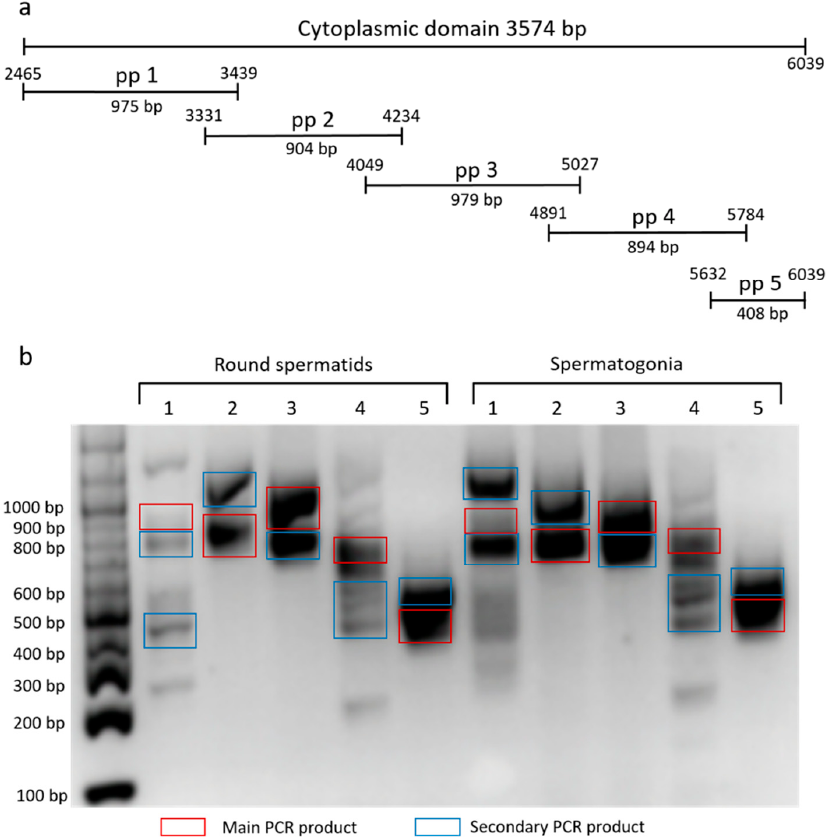
Figure 2. ( a ) Primers designing and ( b ) agarose gel electrophoresis of PCR products involving in the cytoplasmic domain of β 4 integrin. 1–5 PCR products amplified by primer pairs (pp) in mRNA